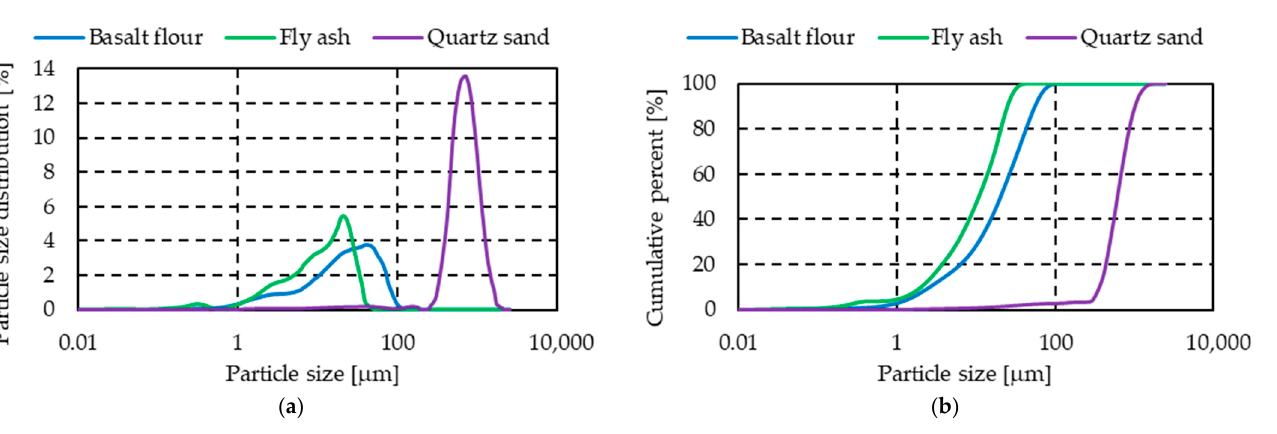
Figure 3. ( a ) The particle size distribution curves for fly ash, quartz sand, and basalt flour; ( b ) the cumulative curves for fly ash, quartz sand, and basalt flour.